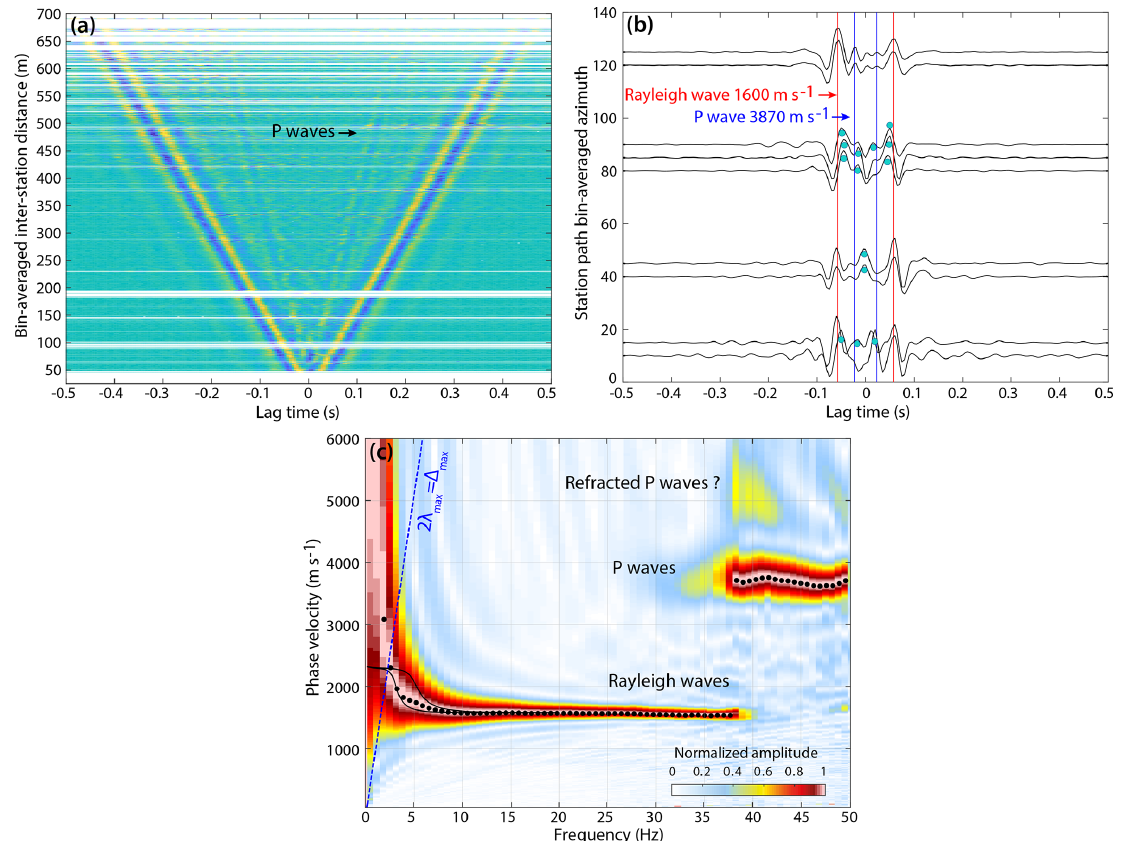
Figure 3. (a) Noise cross-correlations (NCCs) sorted by increasing inter-station distances at Glacier d’Argentière. For the representation, correlation functions are averaged in 1m distance bins and band-pass filtered between 10 and 50Hz to highlight the presence of high- frequency P waves. (b) Azimuthal dependence of GF estimates for pairs of stations 100m apart. Accurate GF estimates are obtained at station paths roughly aligned with the glacier flow (azimuth ∼ 120 ◦ ), indicating more noise sources likely located downstream and upstream of the array. For other station paths, we observe spurious arrivals (indicated by green dots) before the expected arrival times for Rayleigh (red bars) and P waves (blue bars) which primarily arise from non-distributed noise sources that lie outside the stationary phase zones of these stations (see main text). (c) Frequency–velocity diagram obtained from f-k (frequency–wavenumber) analysis of NCC in (a) . The dispersion curve of phase velocity for Rayleigh waves and P waves is plotted as black dots. The dashed blue line shows the frequency-dependent resolution limit, given the maximum wavelength and sensor spacing λ max = (cid:49) max / 2. Black lines are theoretical dispersion curves for fundamental mode Rayleigh wave velocity computed for ice thickness of either 150 or 250m with Geopsy software. We used the elastic parameters for the ice and bedrock as given in Preiswerk and Walter (2018, Sect. 6.1). The same figure for icequake cross-correlations is available in Appendix (Fig.